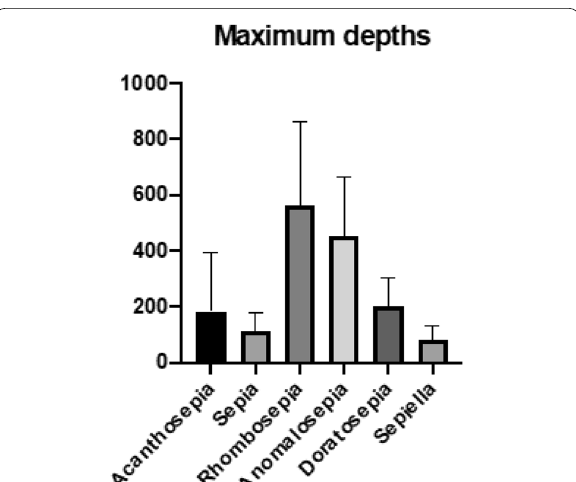
Fig. 12 Maximum depths of Khromov subgenera. The depth ranges of species placed by Khromov into subgenera. These data is consistent with the hypothesis that the Khromov “subgenera” are depth adaptations